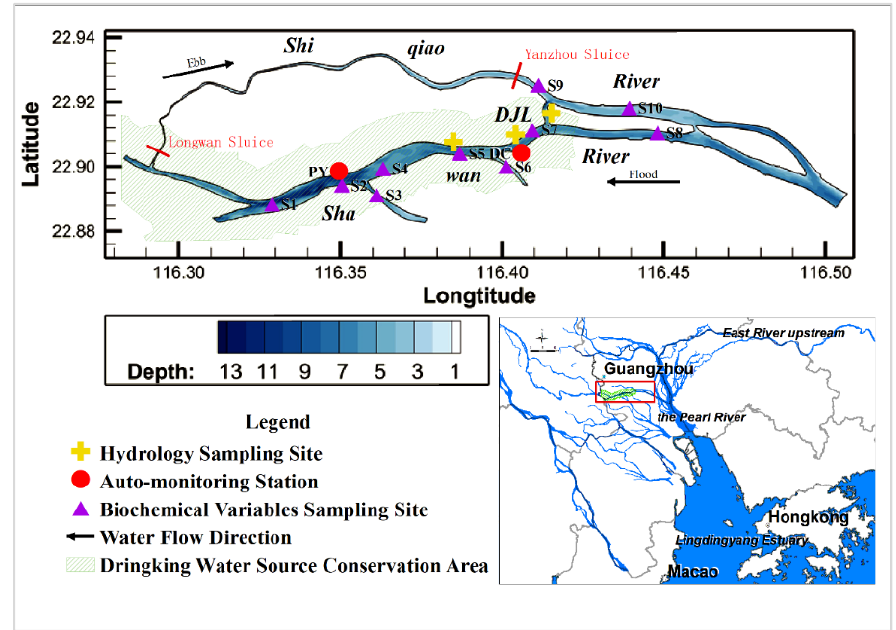
Figure 1. The bathymetry and locations of auto-monitoring stations, sampling sites, and tidal sluices in the Shawan–Shiqiao basin. The inset shows the distribution of the Guangdong–Hong Kong–Macau Greater Bay Area, Pearl River estuary, major tributaries of the Pearl River, together with the location of the Shawan–Shiqiao basin. The Longwan Sluice and Yanzhou Sluice are represented by red lines across the river. The two auto-monitoring sites, Panyu (PY) station and Dongchong (DC) station, are labeled by red dots. The two rivers are connected by the Dajiulv (DJL) channel. Purple triangles indicate the 10 sampling sites of biochemical variables. Yellow crosses indicate the 3 hydrology sampling locations for validation of the numerical simulation. Black arrows depict the di ‐ rection of currents in a tidal cycle, with the Longwan Sluice opening at the flood phase and the Yanzhou Sluice opening at the ebb phase. The locations of drinking water source conservation areas are shaded in green.